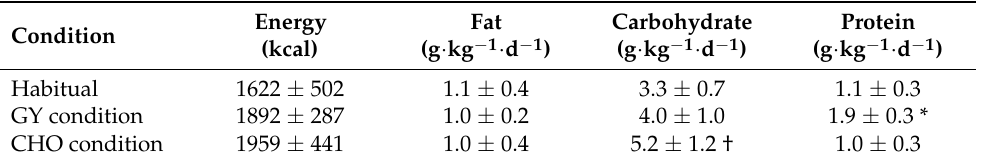
Table 2. Habitual nutrition intake, and intervention nutritional intake of the adolescent female soccer players (N = 13). Values are mean ± standard